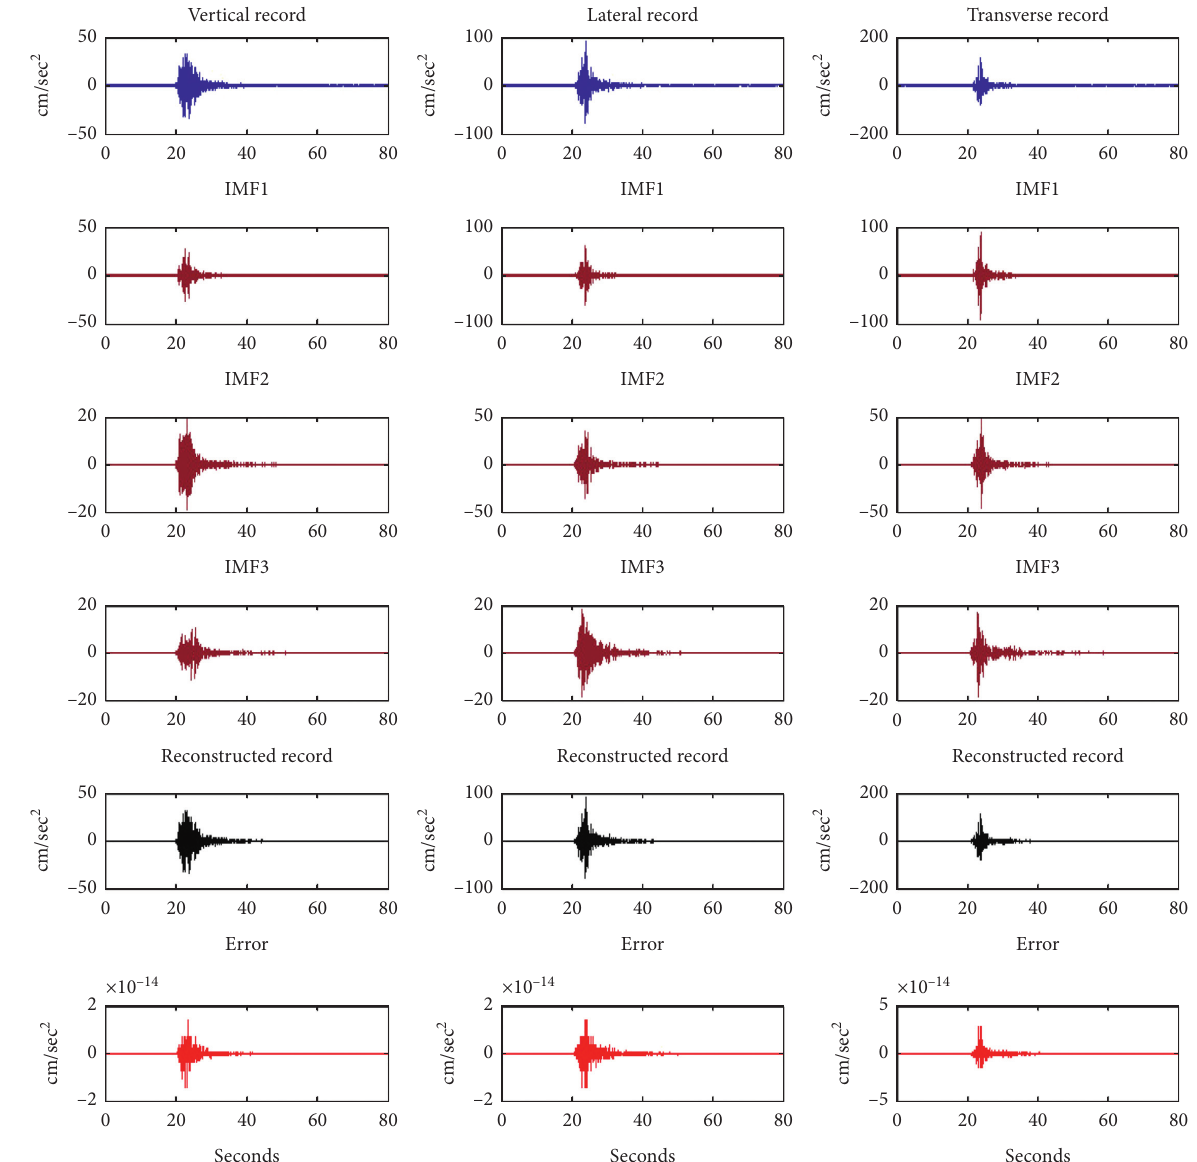
Figure 10: Empirical mode decomposition of the Mosha 2020 earthquake accelerograms recorded in Mosha3